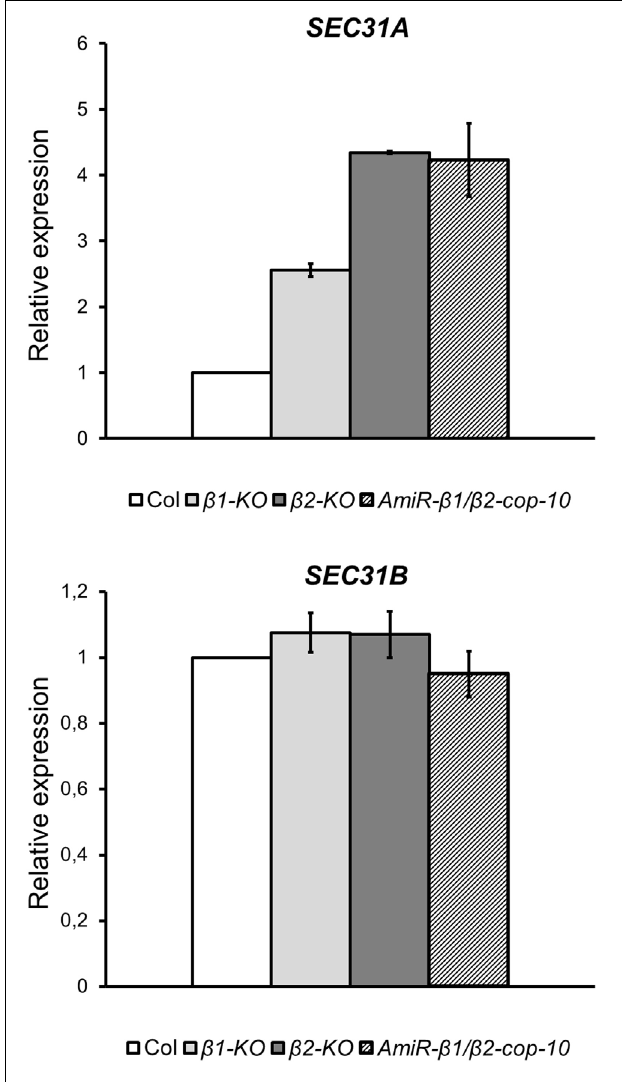
FIGURE 8 | The β 1-cop , β 2-cop and amiR- β 1/ β 2-cop mutants show upregulation of the COPII subunit SEC31A gene. Expression of SEC31A and SEC31B was analyzed by RT-qPCR. Total RNA was extracted from 4-day-old seedlings of wild type (Col-0) and the β -cop mutants. The mRNA was analyzed by RT-qPCR with specific primers (Gimeno-Ferrer et al., 2017) and normalized to UBIQ10 gene expression ( Supplementary Table S2 ). mRNA levels are expressed as relative expression levels and represent fold changes of mutant over wild type. Values represent mean ± s.e.m. of three biological